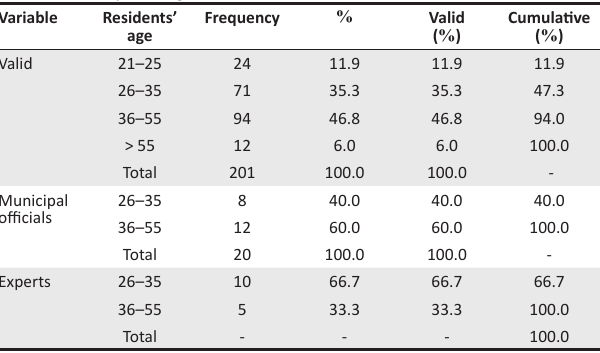
TABLE 3: Participants’ age.